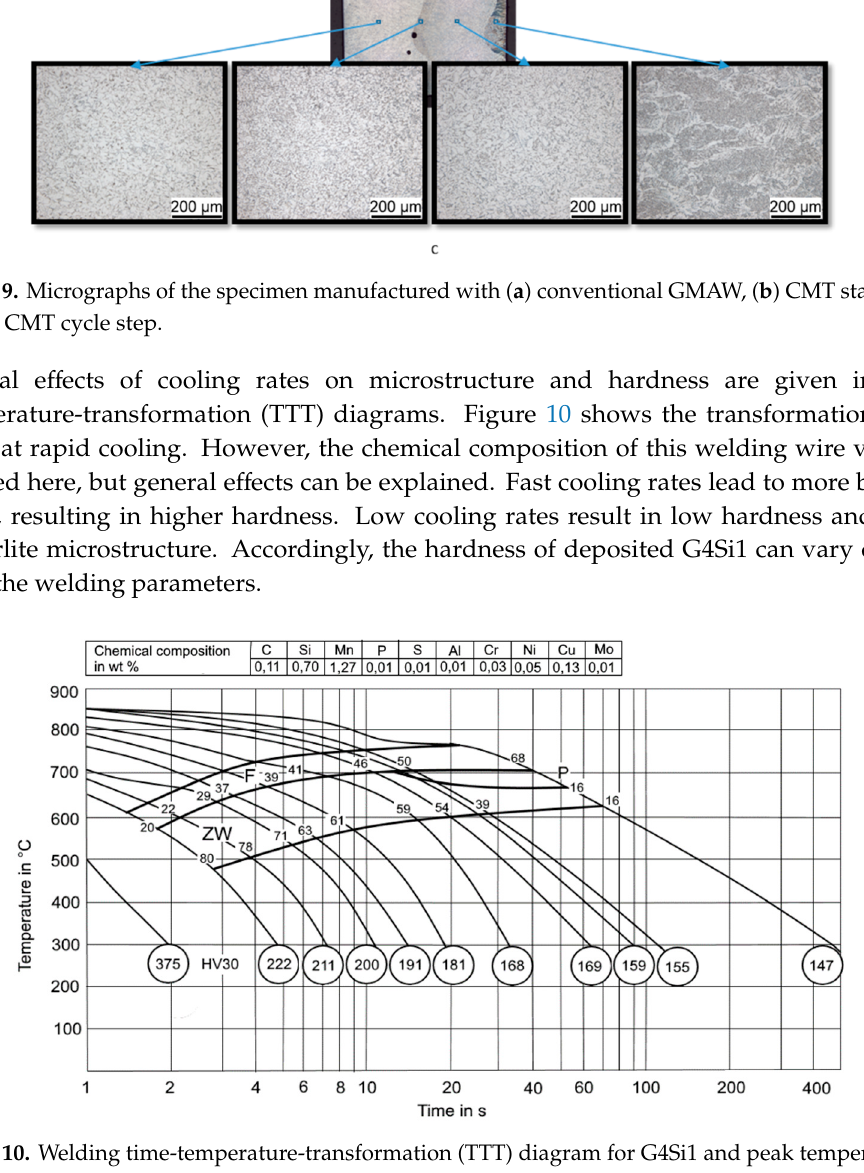
Figure 9. Micrographs of the specimen manufactured with ( a ) conventional GMAW, ( b ) CMT standard, and ( c ) CMT cycle step.